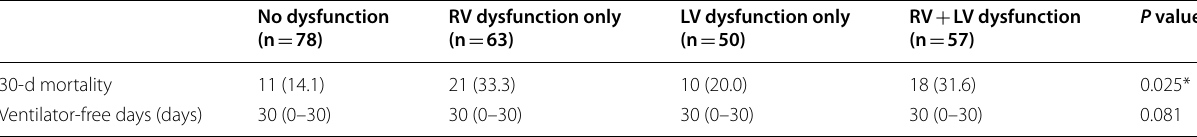
Table 3 Outcome according to ventricular dysfunction subtypes